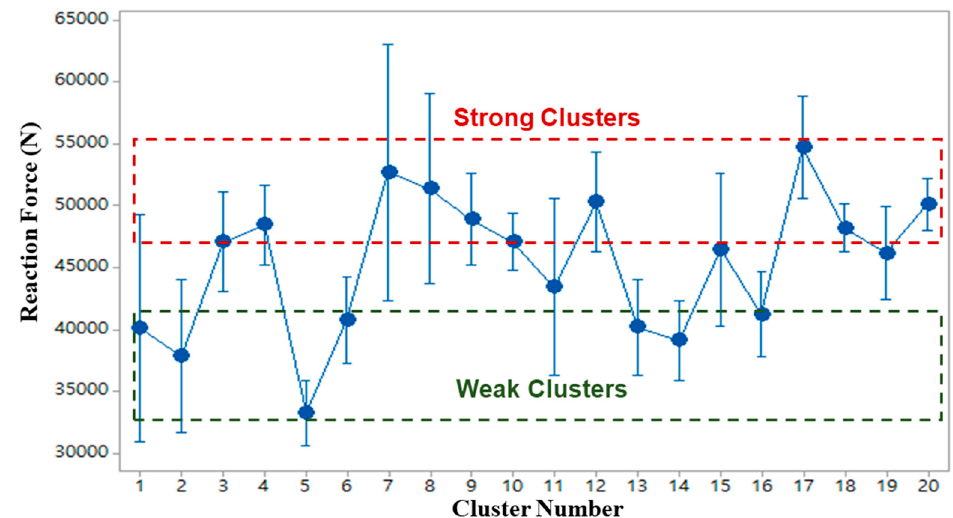
Figure 4. The average reaction force with an error bar at each cluster for the case of 20 clusters, defining strong and weak clusters.